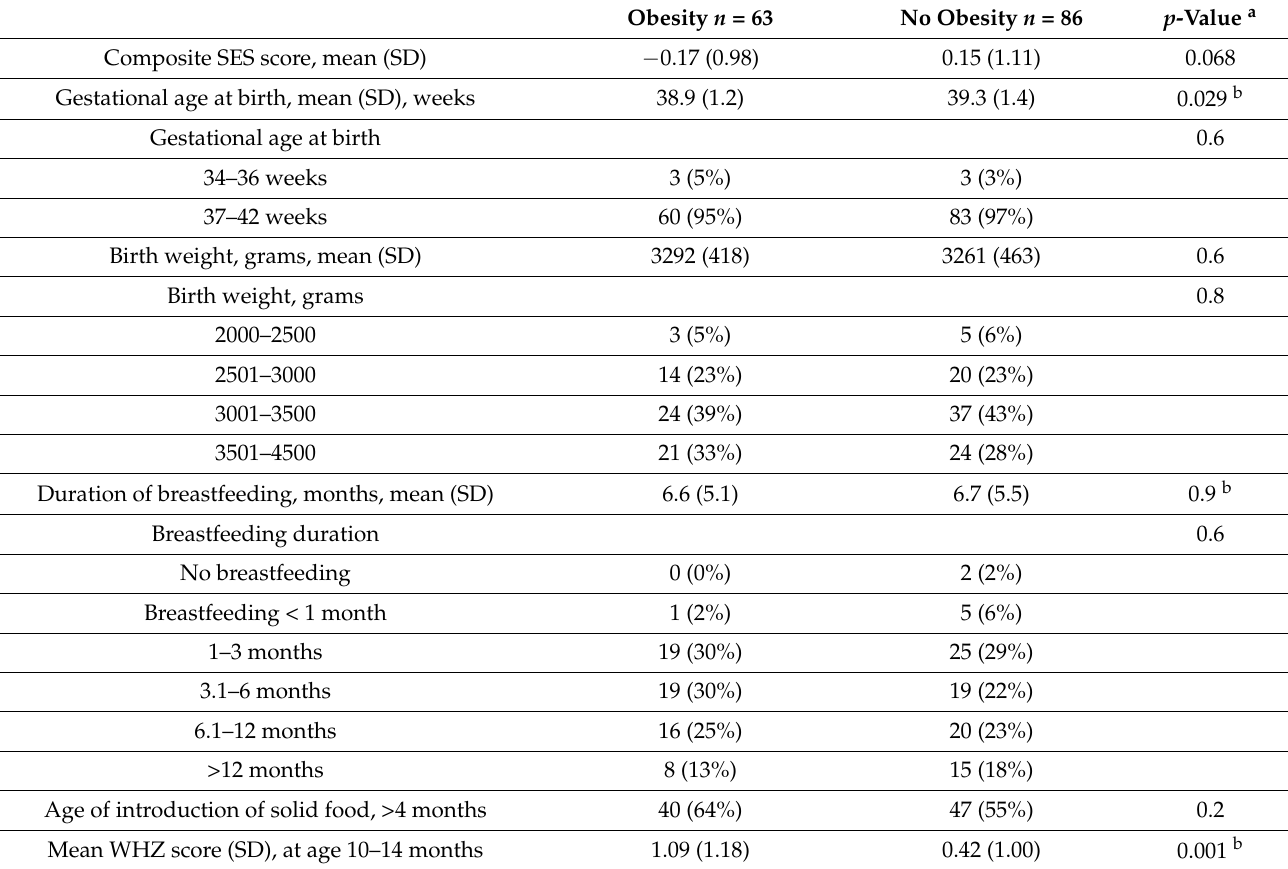
Table 2. Associations of sociodemographic and early life exposures with obesity in children aged 10–12